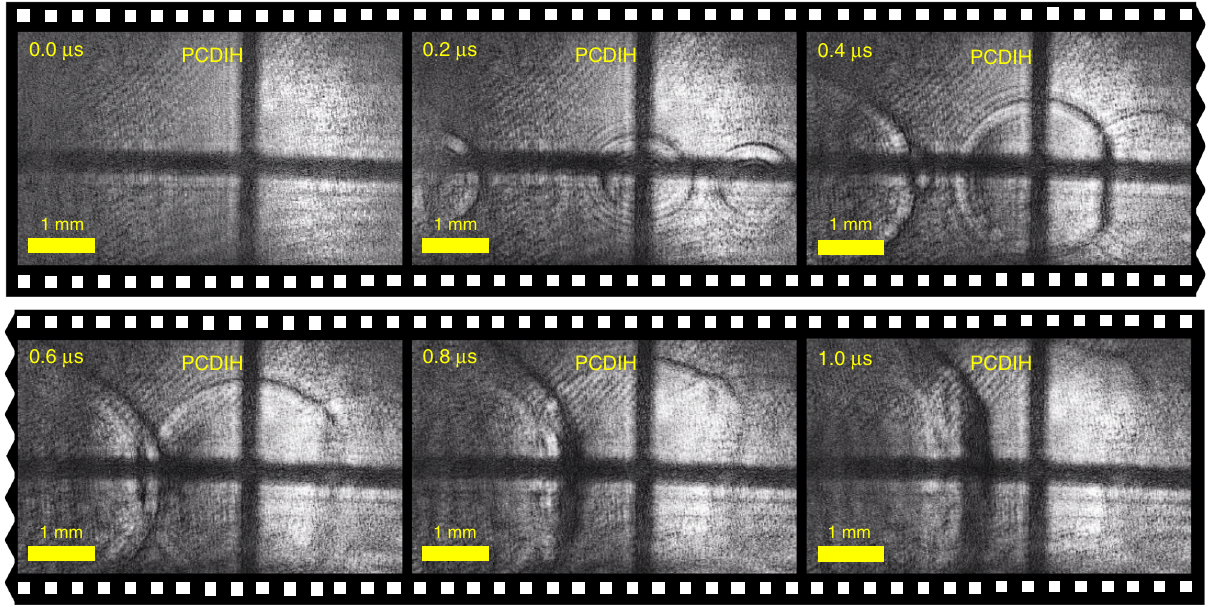
Fig. 6 Shock – wave interactions collected at 5 MHz with PCDIH. In this example produced with the same laser-spark energy as Fig. 5, the plasma does not overwhelm the PCDIH signal. Additionally, shock – wave interactions can be